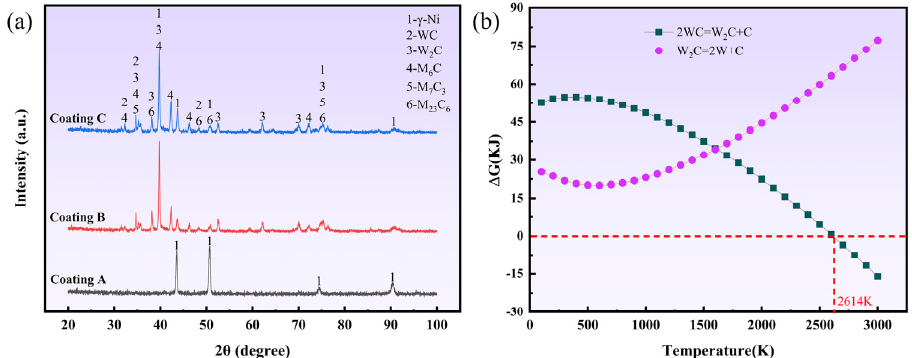
Figure 5. ( a ) XRD patterns of the three coatings; ( b ) relationship between temperature and free en-